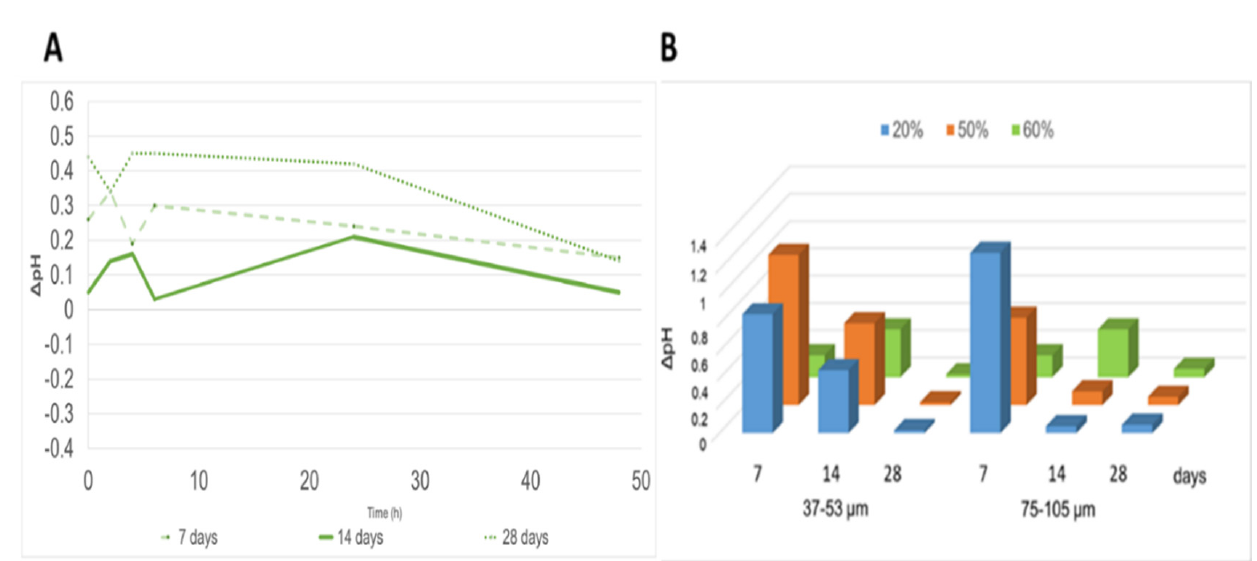
Figure 1. ∆ pH with GP reported: ( A ) vs. time for GP/WG 60% (37–53 μ m) aged 7, 14, and 28 days and ( B ) for both series as a function of curing time and WG percentage.